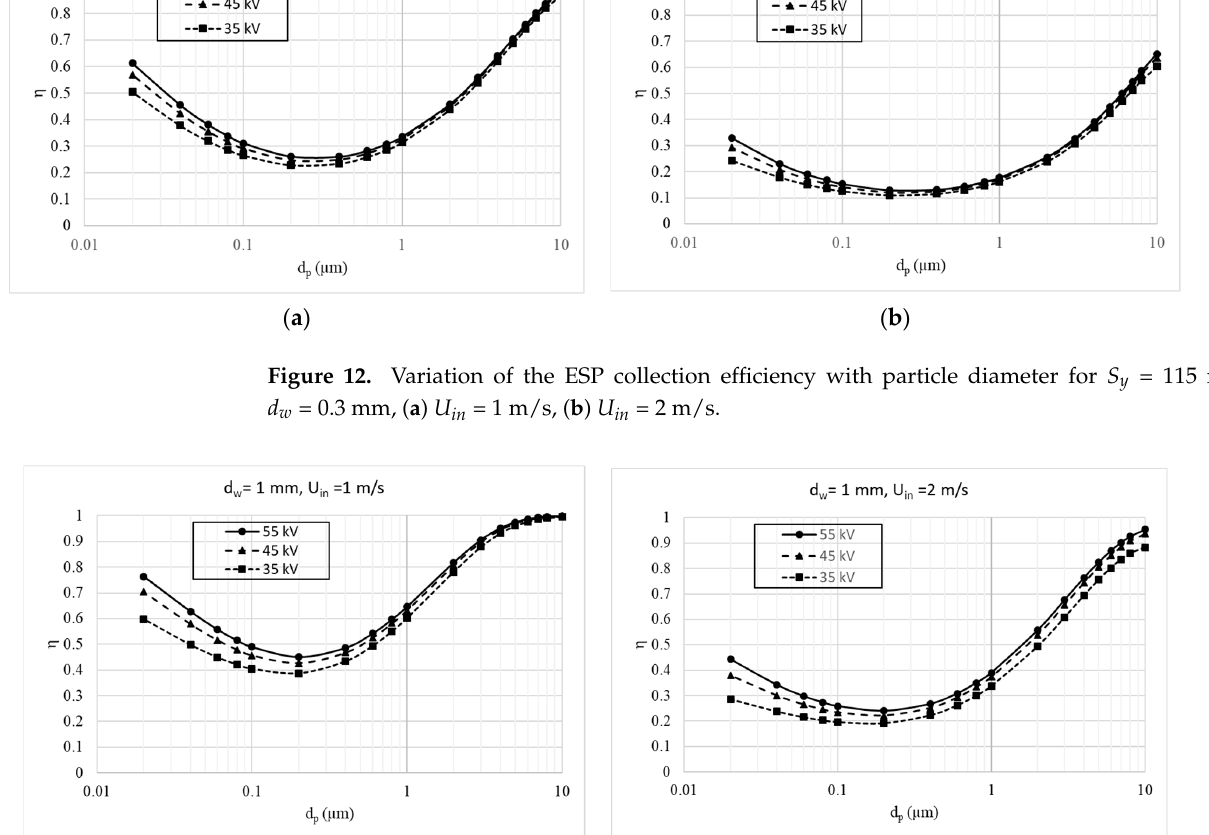
Figure 14. Variation of the ESP collection efficiency with particle diameter for S y = 115 mm, d w = 2 mm, ( a ) U in = 1 m/s, ( b ) U in = 2 m/s. Figures 15–17 show the calculated collection efficiency variation with the particle di- ameters for different operating conditions in the 180 mm width channels by using d w = 0.3 mm, 1 mm, and 2 mm corona wire diameters, respectively. Similar observations for the